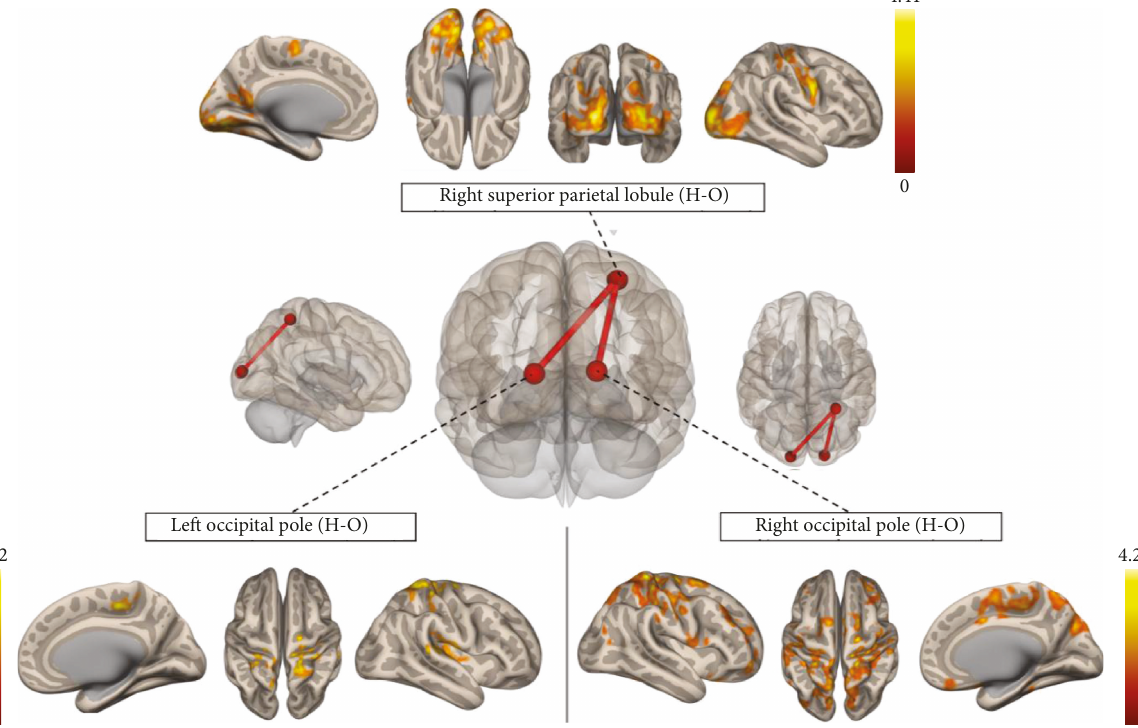
Figure 5: Visual search reaction time performance explained by resting state functional connectivity. ROI-to-ROI analyses revealed an increase in the right superior parietal lobule and bilateral occipital pole pathway, which may account for the better performance of the karate group (centre). Seed-to-voxel results, thresholded ( p < 0 05 , FDR corrected), are shown for each of the 3 nodes. Unthresholded pattern activation is shown in Figure S3 supplementary materials. All voxels with signi fi cant connectivity changes are shown in the fi gure and listed in Table S2, Supplementary materials. Note: H-O: